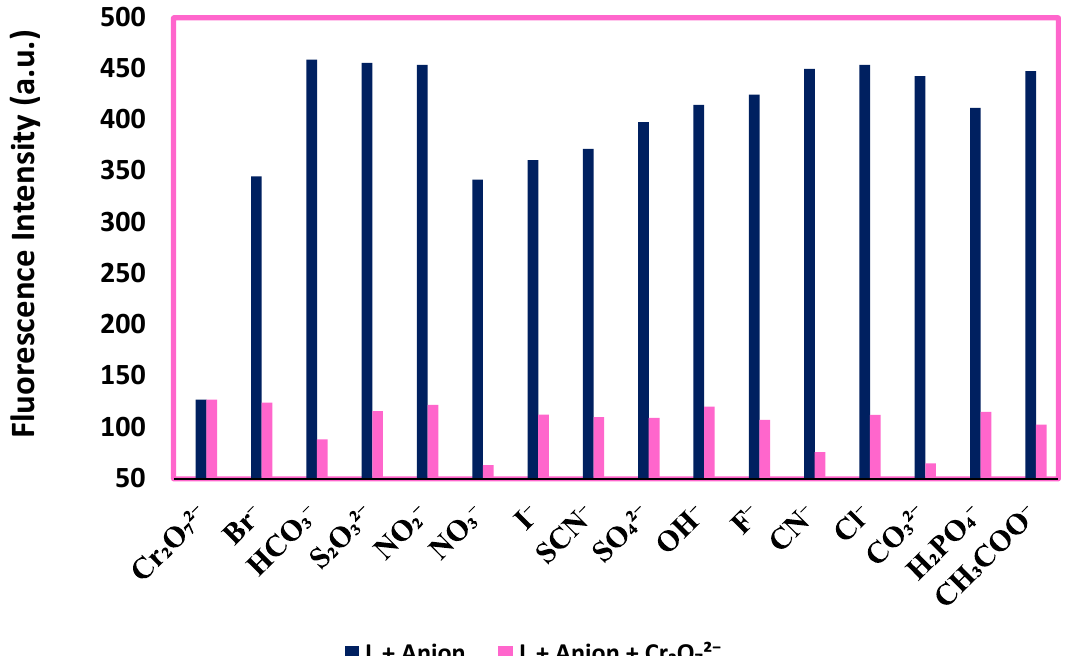
Figure 12. Selectivity of SBA-Pr-Is-TAP (3 mL H ₂ O suspension, 0.2 g L − ¹) for Cr ₂ O ₇ ² ⁻ (100 µL, 1 × 10 − 4 M) in the presence of equal amounts of anions ( λ ex = 255 nm and λ em = 420 nm).